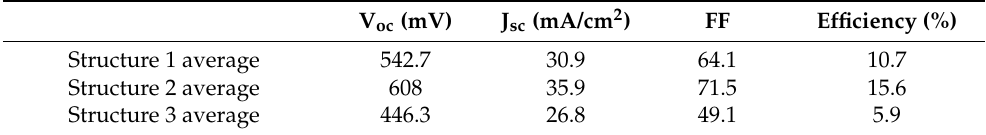
Table 2. The performance of cells.